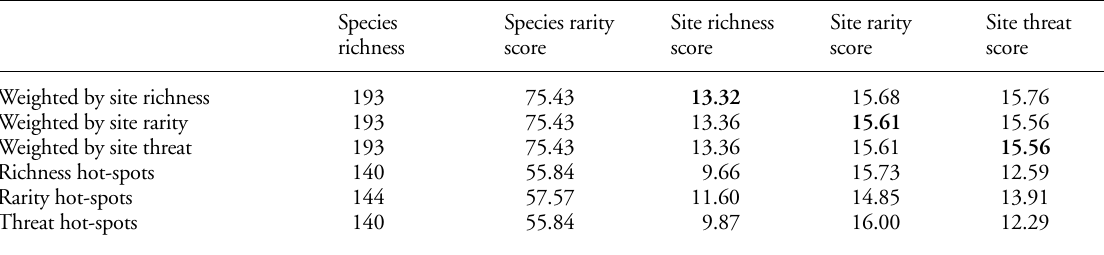
Table 1. Pay-off table of the three criteria values for each single objective function solution (26 sites), and the corresponding values for the richness, rarity, and threat hot-spot solutions. Species represented and species rarity score for each one of the solutions were added for comparison reasons between the SCP solutions and the hot-spot ones. Bold values are the optimum scores found according to site richness, site rarity and site threat